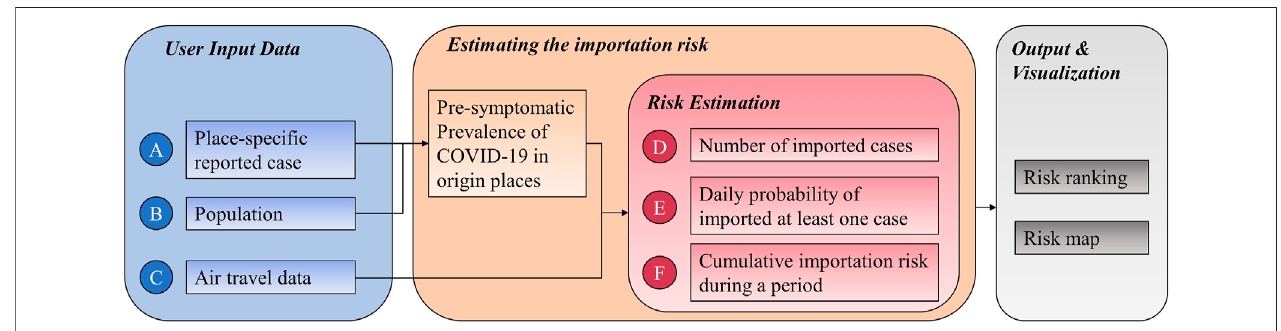
FIGURE 1 | An illustration of the proposed framework to estimate the importation risk. This modeling framework includes three main modules [1]: the module of user input data is used to store data submitted by the users, such as daily reported cases and air travel fl ow [2]; the module of estimating the importation risk is used